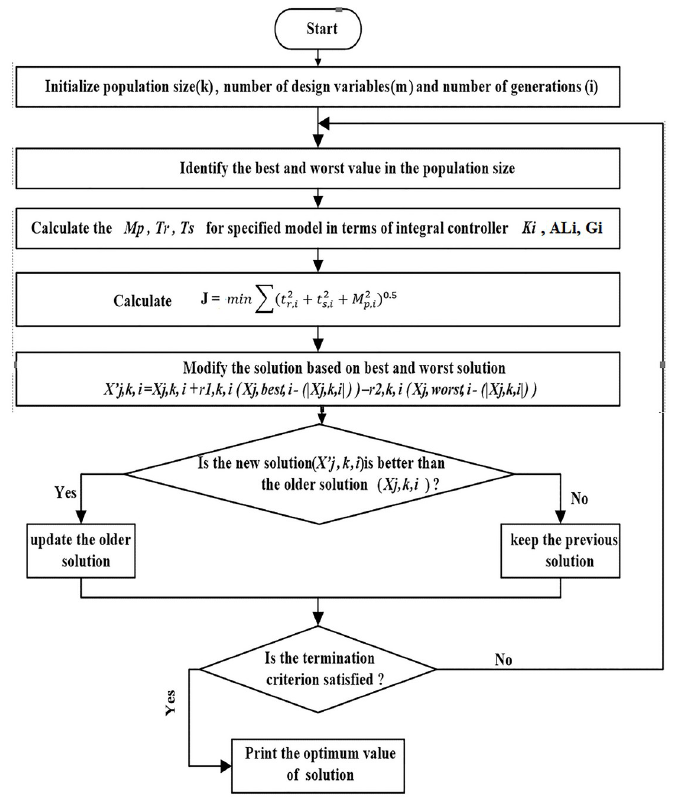
Fig 7. Flowchart of